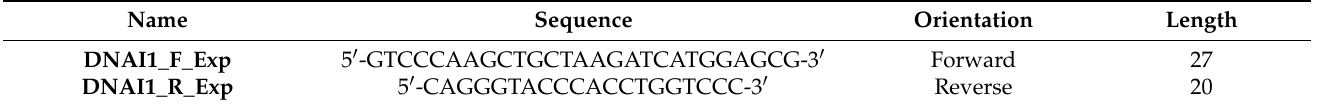
Table 2. Primers for the DNAI1 gene